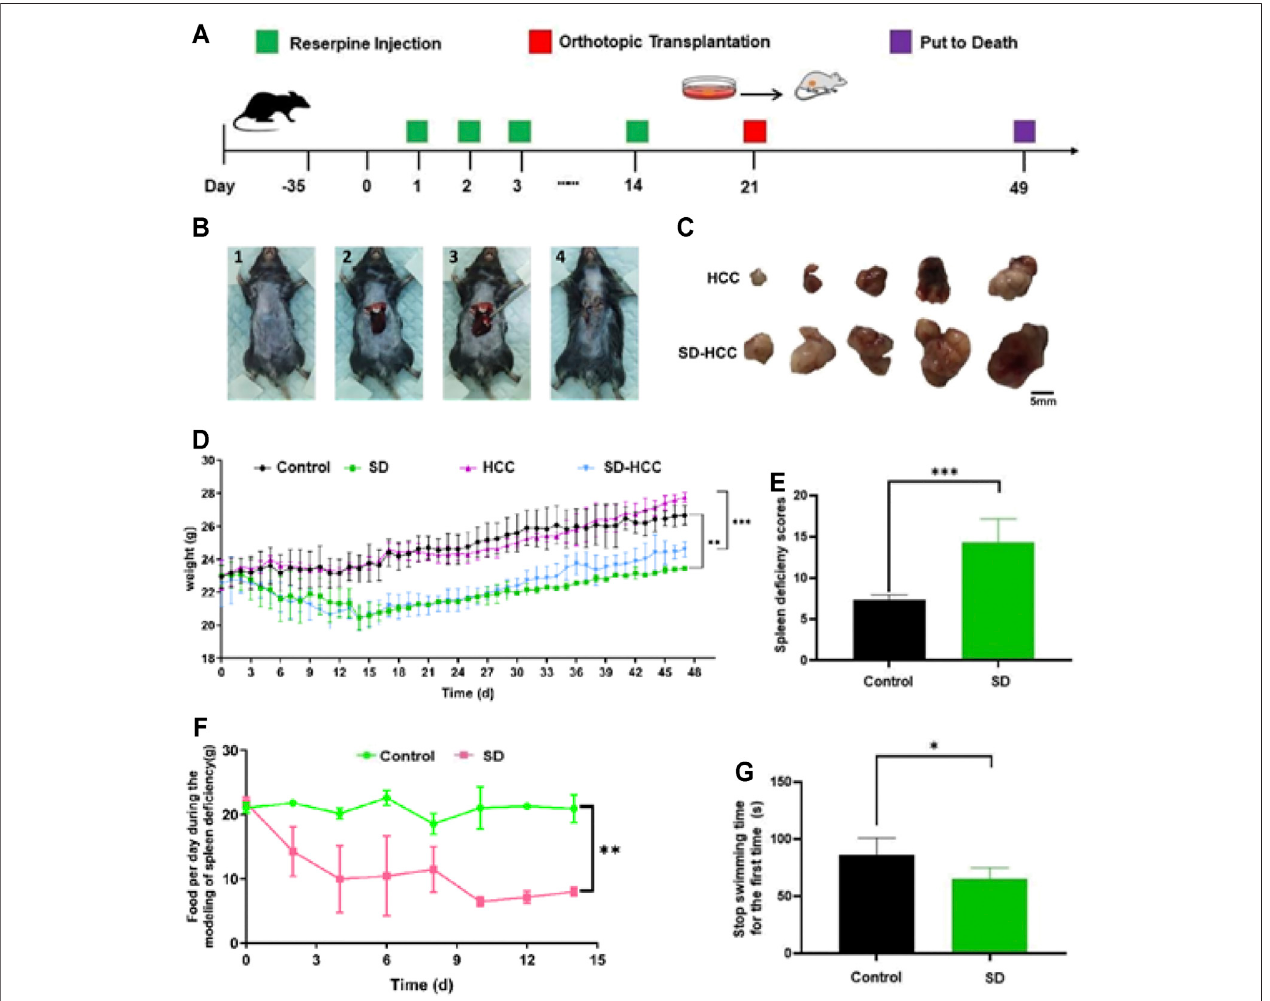
FIGURE 1 | Preparation of orthotopic transplantation liver cancer model with SD. (A) Flow chart; (B) transplantation process: 1) shave and disinfect the surgical area,2)squeezeouttheliverlobe,3)inoculatethetumormass,4)suturethewound; (C) comparisonoftumorsize; (D) bodyweightchangecurve; (E) SDscorestatistics; (F) changes in the diet of mice during the preparation of SD model; (G) stop swimming time statistics. n (cid:2) 3, * p < 0.05, ** p < 0.01, *** p < 0.001.